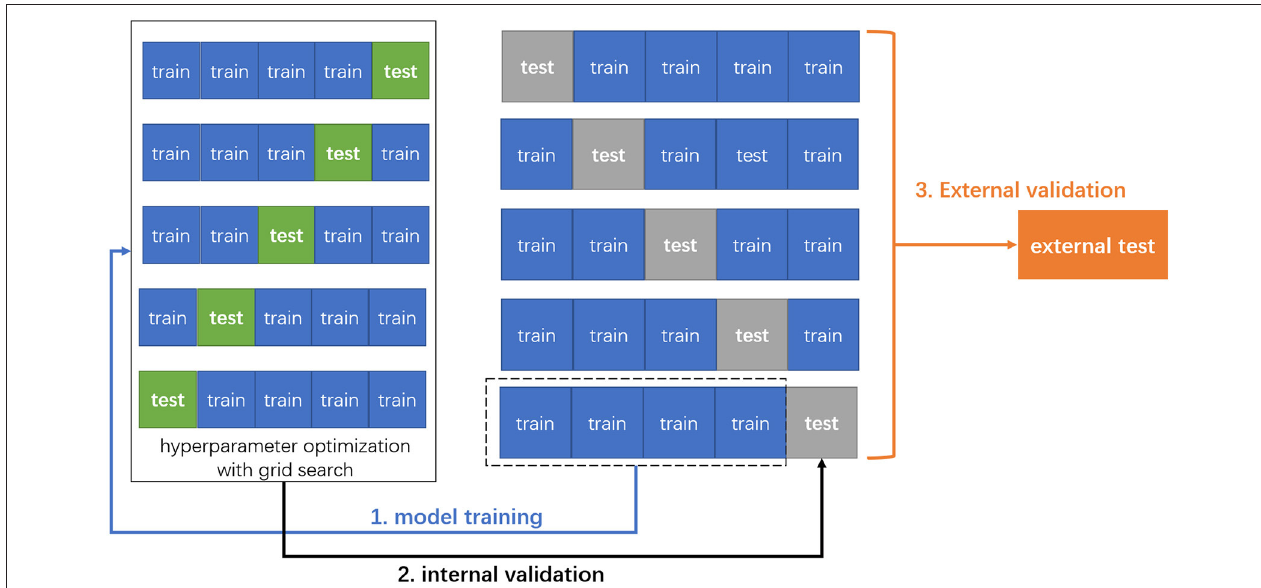
FIGURE 1 | The schema of 5-fold cross-validation and external validation. First, the original data were randomly divided into five patterns without duplication, one of which was used as the test set, and the remaining four as the training set for model training. Next, we adapted grid search with 5-fold cross-validation to optimize the hyperparameters for each machine learning model. Finally, the trained models were externally validated on the external test